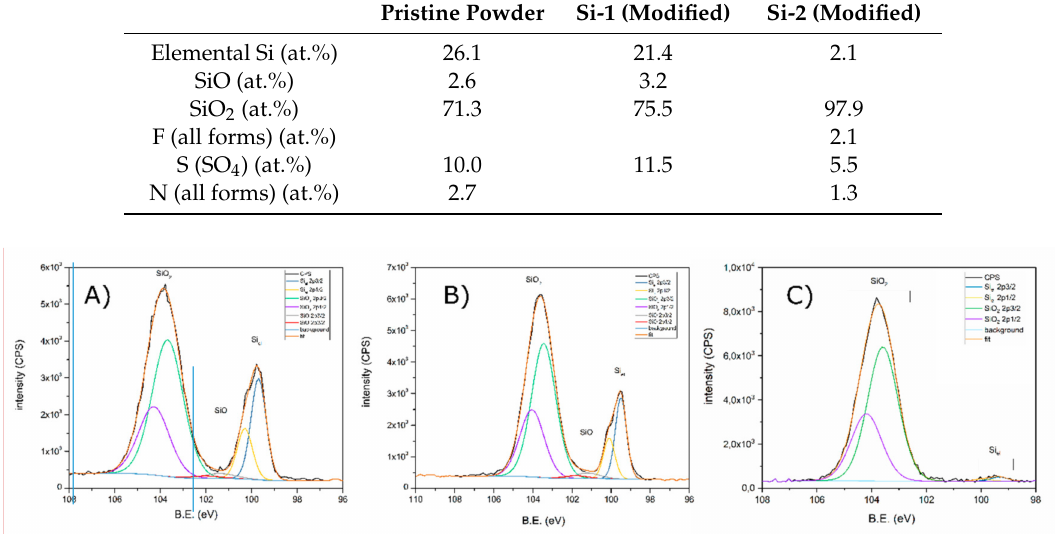
Figure 1. Si 2p band revealed by high-resolution XPS measurement for pristine powder ( A ), after modification 1 ( B ), and modification 2 ( C